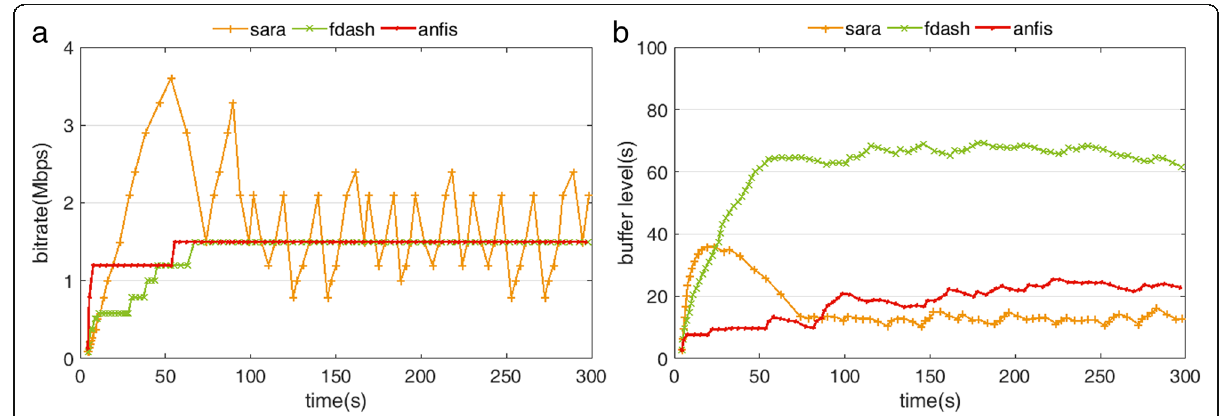
Fig. 9 Simulation results in second LTE environment. a The segment bit rate requested by client over time. b The client ’ s playback buffer